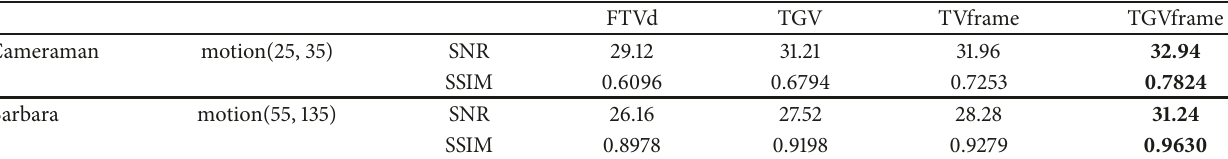
Table 3: Restoration results of different methods under motion blur with noise level 𝜎 = 0.02